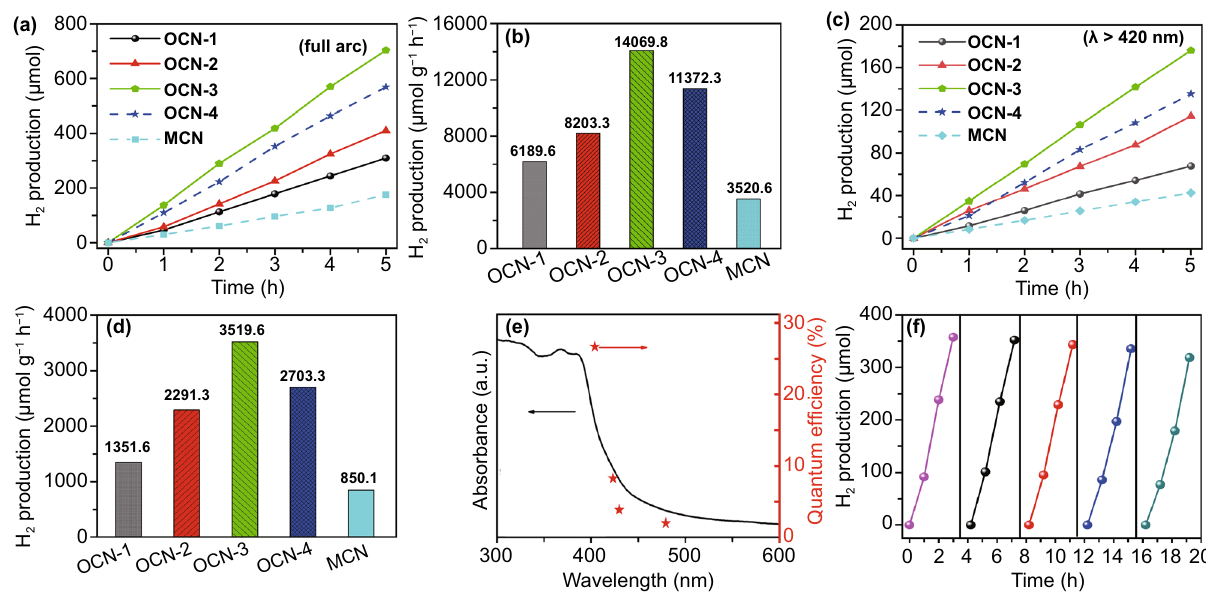
Fig. 3 a – d Time course of hydrogen evolution and comparison of hydrogen evolution rates over 5 h for different simples under a 300 W Xe lamp without an optical filter (full arc, a , b ) and with a optical filter ( λ > 420 nm, c , d ), e–f QE against light wavelength and cyclic photocatalytic H 2 evolution curve of